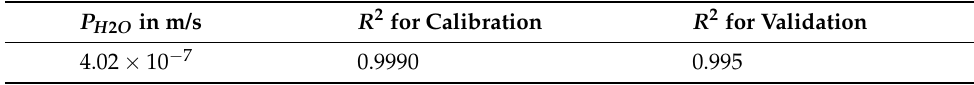
Table 6. Results of the calibration process of the membrane permeability for